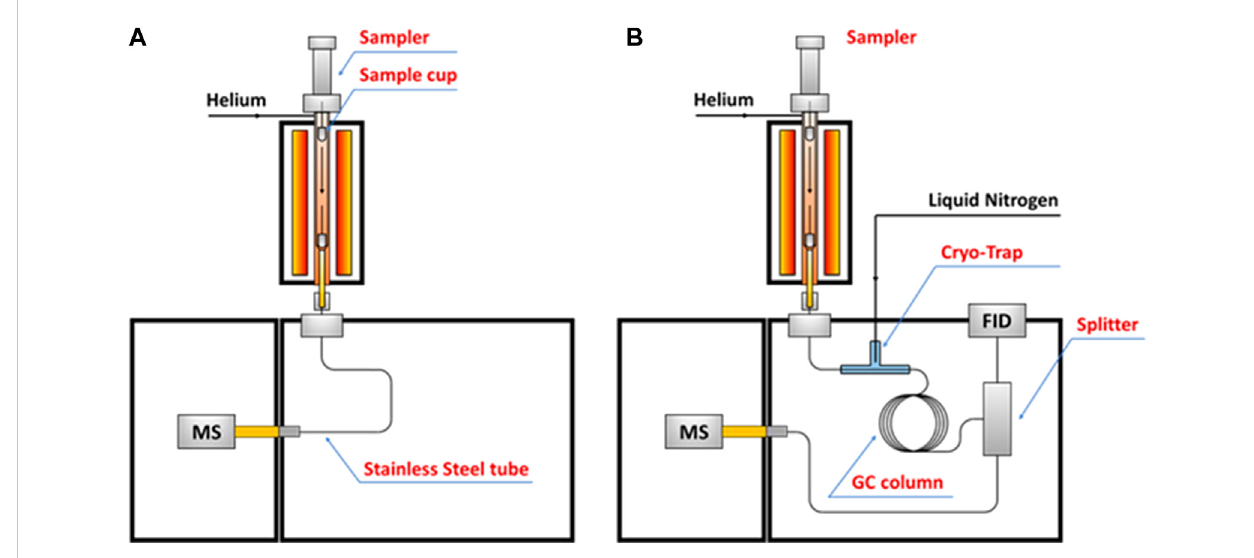
FIGURE 5 Schematic diagrams of (A) EGA-MS and (B) HC-GC-MS in this study (Li W et al.,